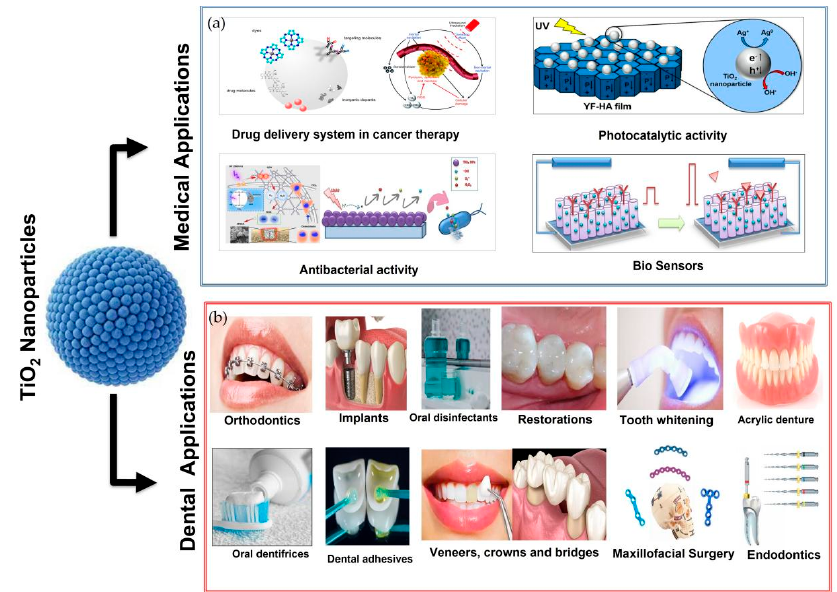
Figure 14. Medical and dental applications of TiO 2 NPs: ( a ) drug delivery in cancer therapy, photo- catalytic activity, antibacterial activity, and bio sensors in medical field; ( b ) orthodontics, implants, oral disinfectants, restorations, tooth whitening, acrylic dentures, oral dentifrices, dental adhesives, veneers, crowns, bridges, maxillofacial surgery, and endodontics in dental field (idea adapted from the ref [351,352]).